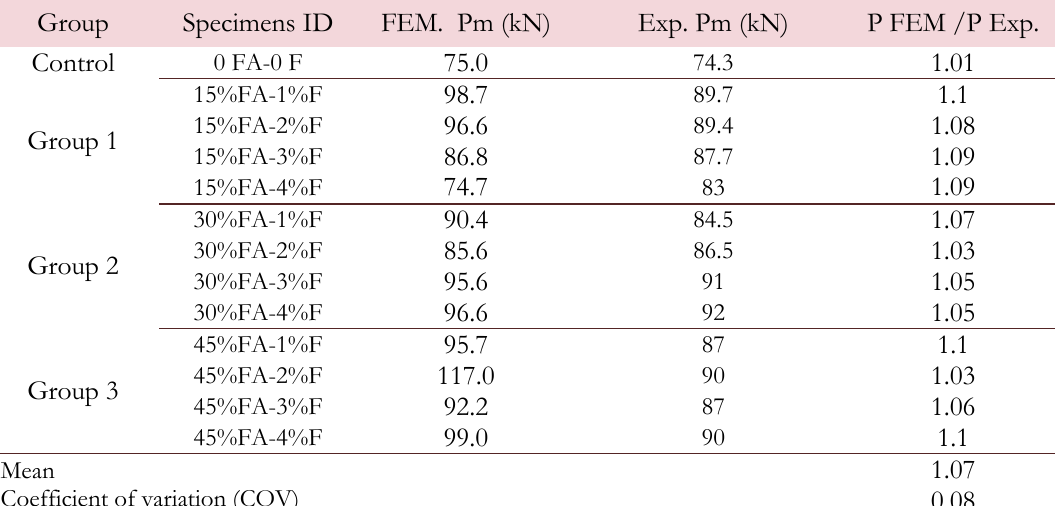
Table 7: FEM results versus experimental